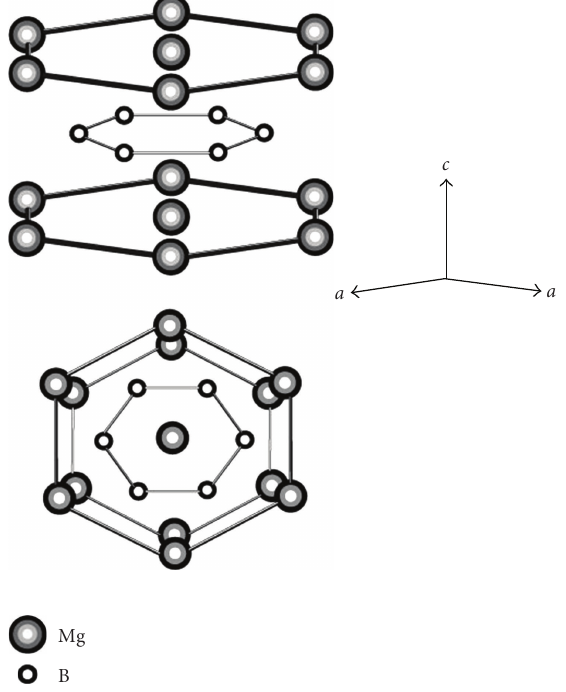
Figure 1: (From [1]) Crystal structure of MgB 2 , of the space group P 6 /mmm (#191). MgB 2 is composed of interleaved Mg and B layers. c (cid:2) Nature publishing group. close as the temperature increases to 39 K. Choi et al . [8]